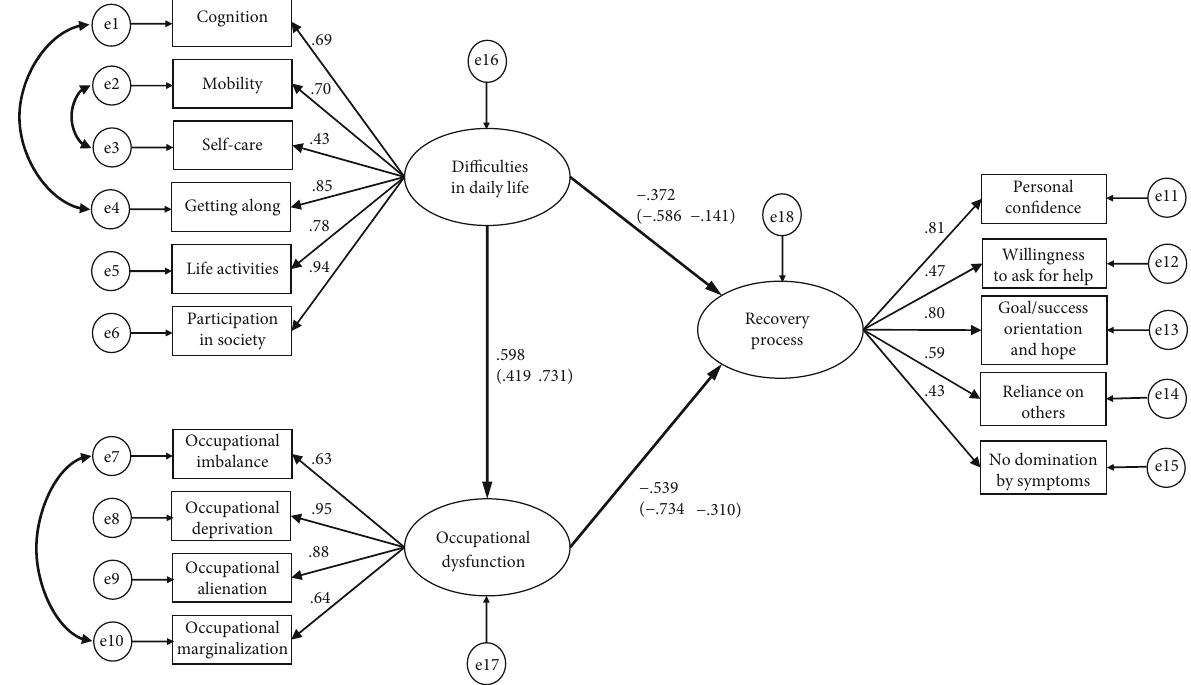
Figure 2: Structural relationship between the recovery process and di ffi culties in daily life mediated by occupational dysfunction using Bayesian structural equation modeling. The values in this fi gure indicate the standardized path coe ffi cients (95% con fi dence